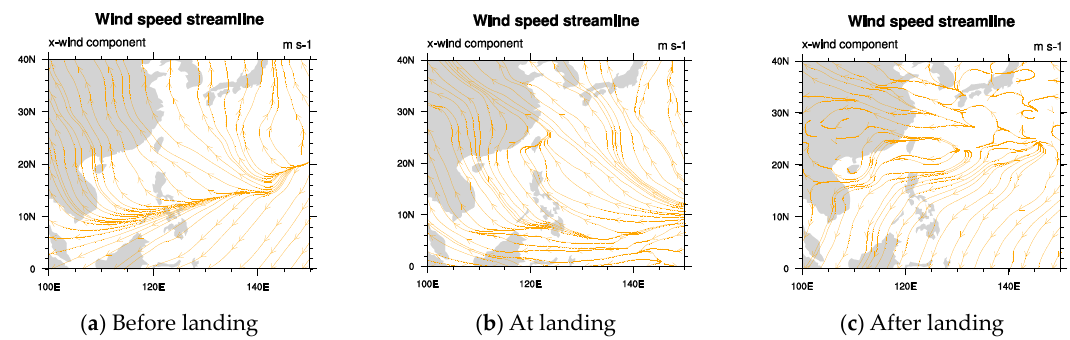
Figure 4. Wind speed streamline before, at and after the landing of the typhoon.